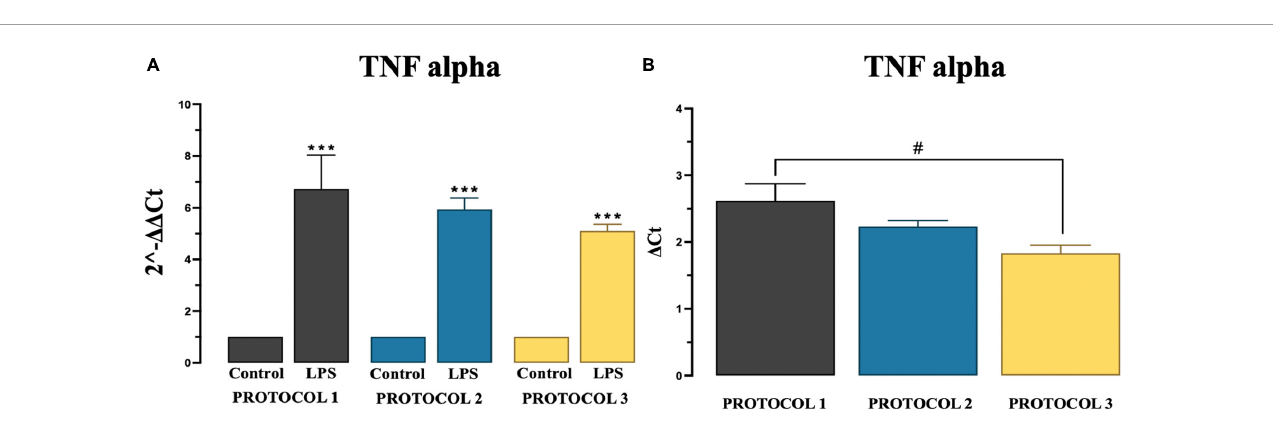
FIGURE6 Evaluation of TNF alpha gene expression. (A) Graphical representation of TNF-alpha showing a significant fold increase in expression in LPS groups compared to control groups. (B) Comparison of TNF alpha gene expression among protocols after LPS treatment. Data are presented as mean ± SEM; N = 3. *** p < 0.001 compared to the control groups. PROTOCOL 1 shows a higher gene expression than PROTOCOL 3, # p < 0.05 for LPS treated groups.